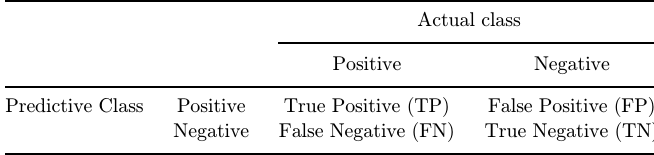
Table 2. Confusion